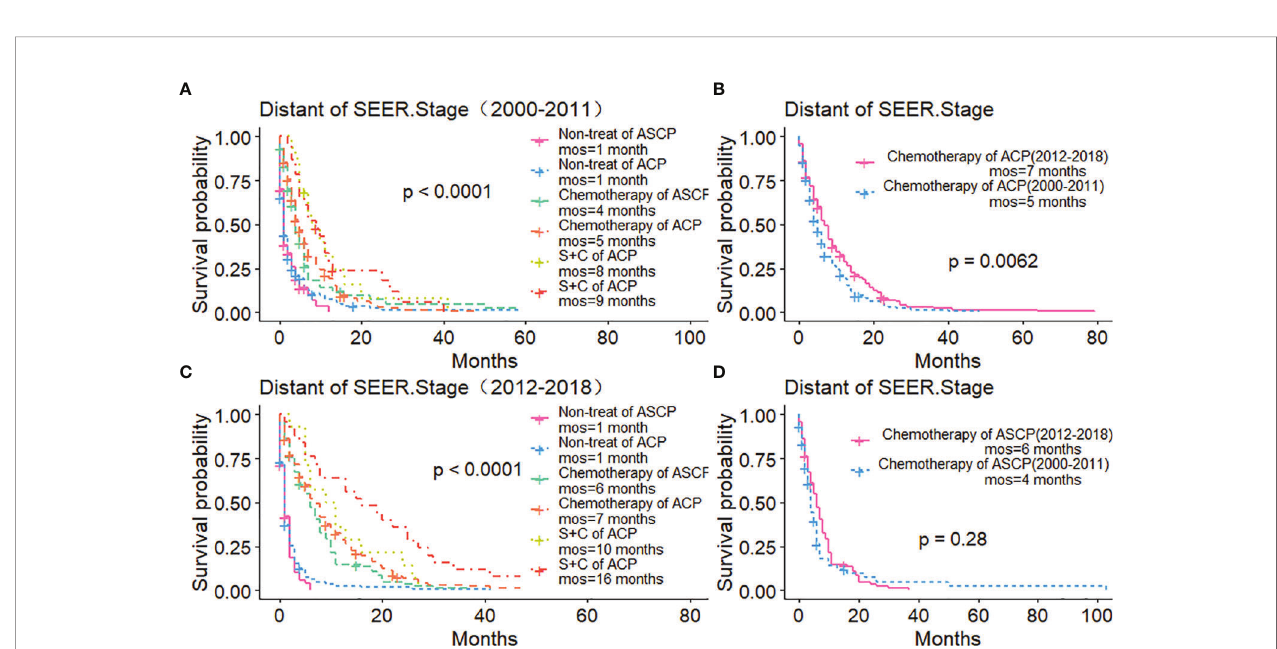
FIGURE 6 | Role of Chemotherapy in ACP and ASCP (2000 – 2011 and 2012 – 2018): (A, C) Comparison of Treatment Methods between ACP and ASCP in Distant Stage; (B, D) Comparison of Chemotherapy Ef fi cacy between ACP and ASCP in Different Time Periods in Distant Stage (S, surgery; C,